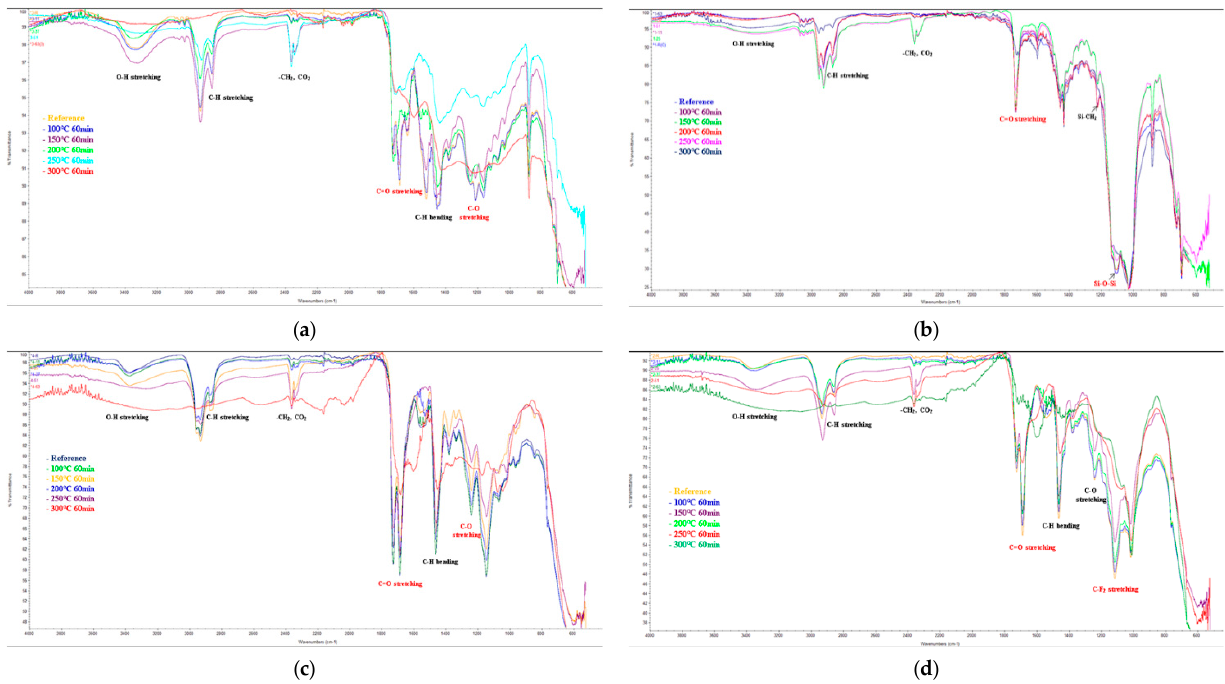
Figure 10. Fourier-transform infrared spectra under varying conditions of temperature from 100 °C to 300 °C: ( a ) urethane; ( b ) siloxane; ( c ) ceramic; ( d ) fluorocarbon.